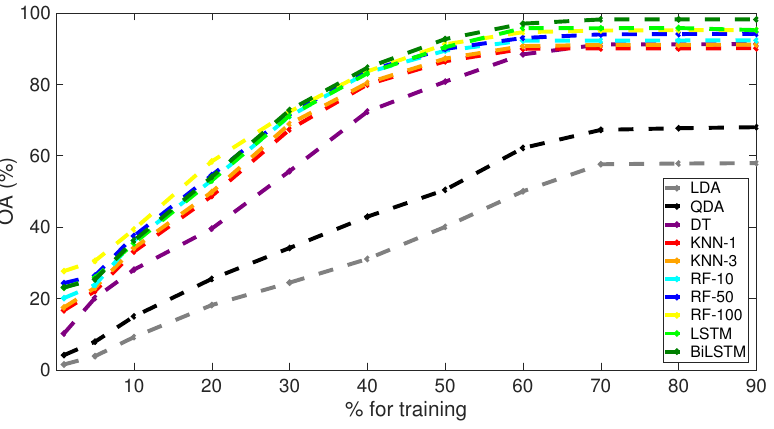
Figure 7. Effect of increasing training dataset